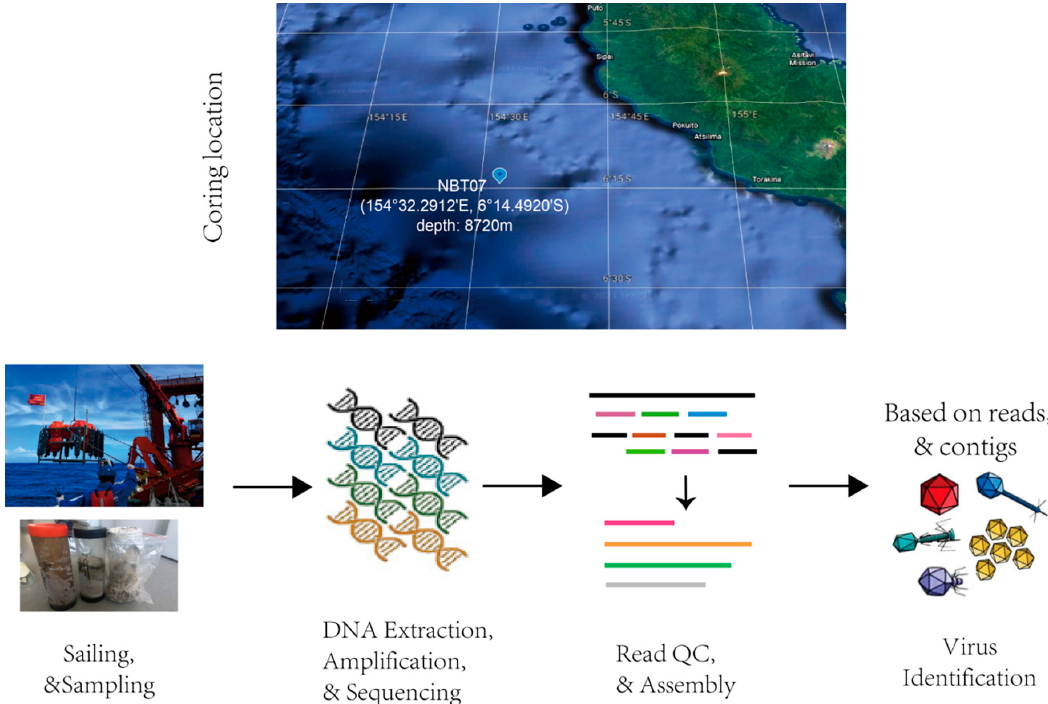
Figure 1. Overview of the study pipeline. Sampling of the hadal sediment in the New Britain Trench (154°32.2912 ′ E, 6°14.4920 ′ S) at a depth of 8720 m. One core was collected in January 2017; the coring location is indicated on the top panel.